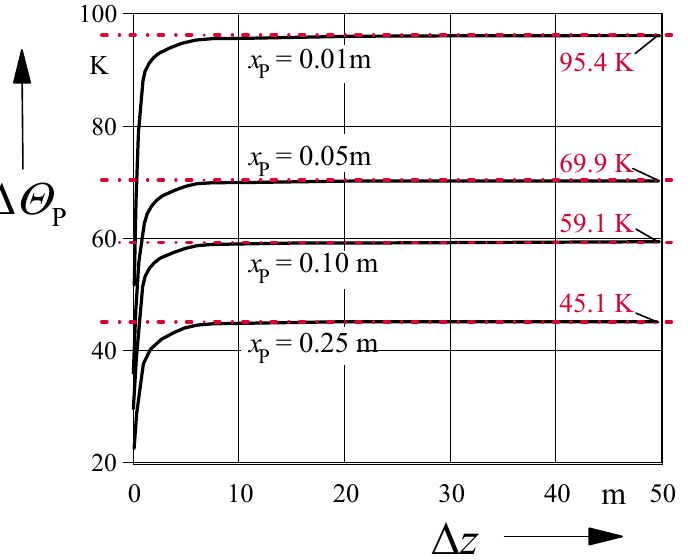
Figure 5. Temperature deviation in a considered point from Figure 3 at a distance of ∆ z from the end of the finite line source; parameter: distance x P from the z ‐ axis; depth: y = 2.0 m (dotted lines correspond to an infinite line source).